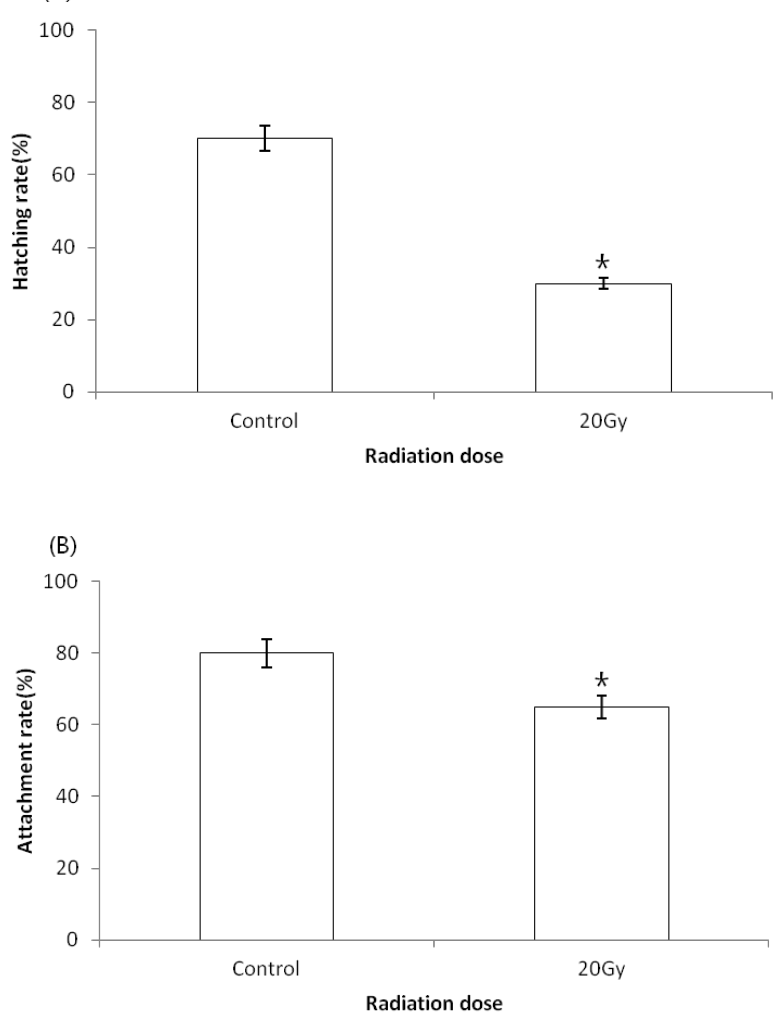
Figure 4. Hatching rate ( A ) and attachment rate ( B ) for each gamma-ray dose. * p < 0.05 for control.